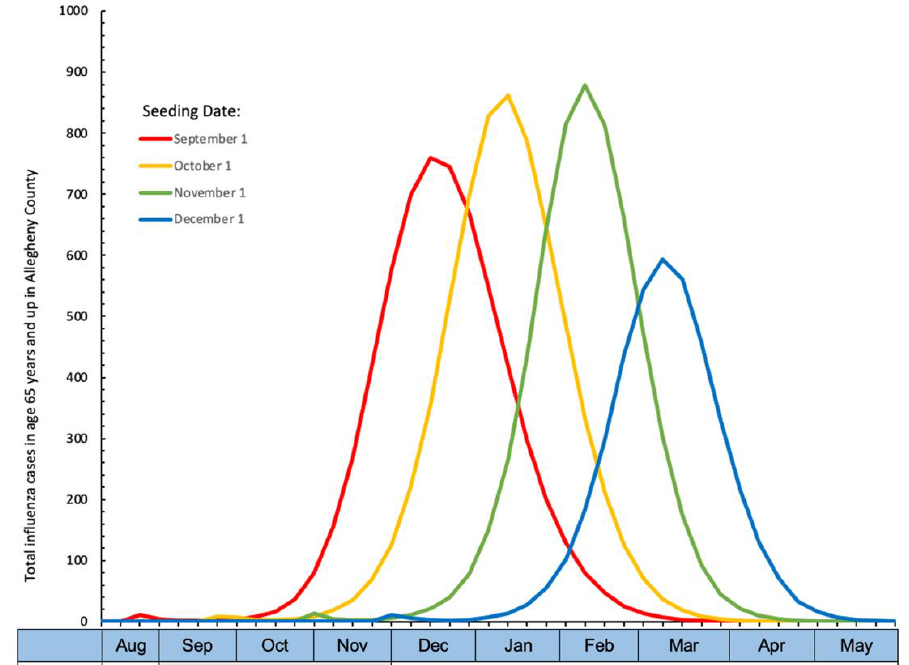
Figure 1. Epidemiologic curve by seeding date. Season peaks by seeding date with one dose of influenza vaccine starting 1 September over a mean of 45 days following a normal distribution. Variations in total cases by season peak are due to incorporation of the seasonal transmissibility parameter in the model to simulate seasonal outbreaks of the same influenza strain that peak at different times.